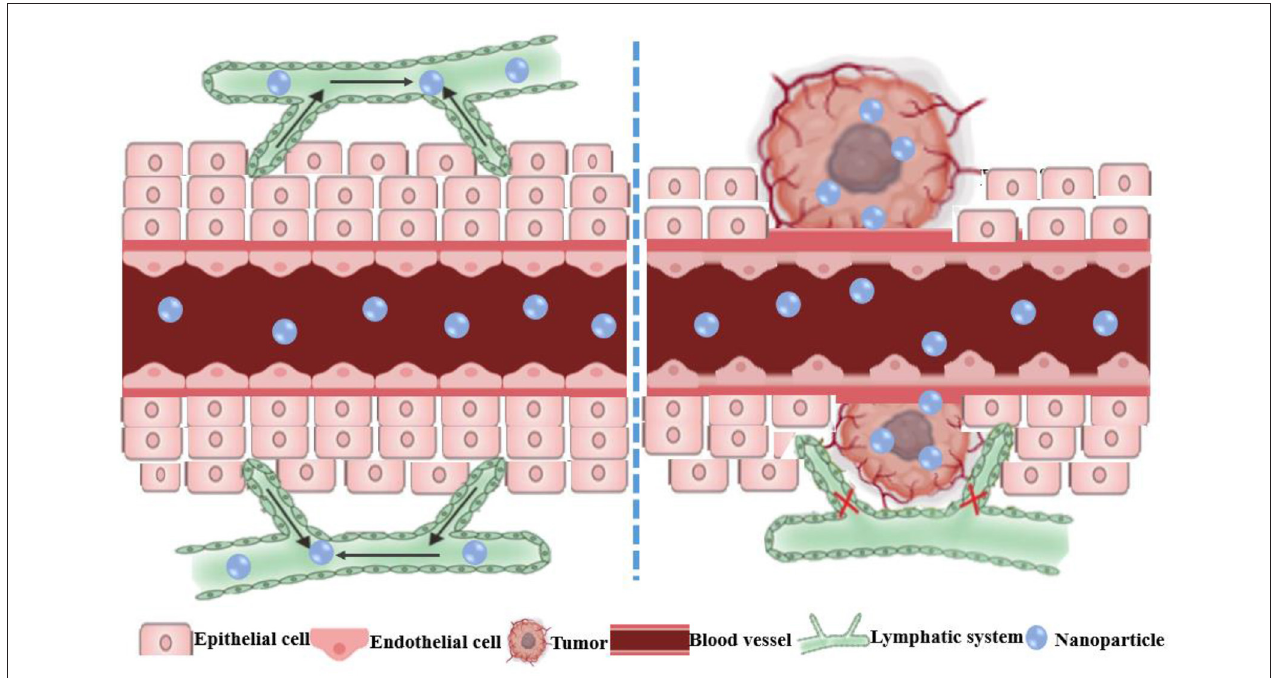
FIGURE 2 | Schematic diagram of the enhanced permeability and retention (EPR) effect of nanoparticles in tumors. The normal tissue has tight vascular endothelial to prevent the extravasation of macromolecules. The EPR effect is the result of the leaky vasculature and ineffective lymphatic drainage of the newborn tumor blood vessels, which results in the retention of macromolecules in the